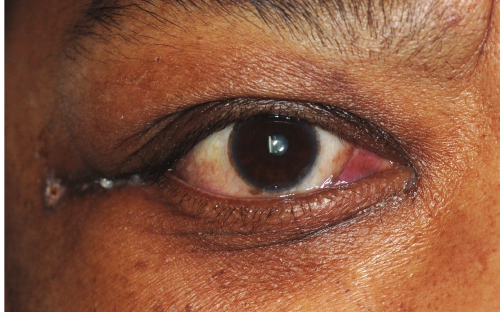
Figure 3: Presentation of the right eye after radiation